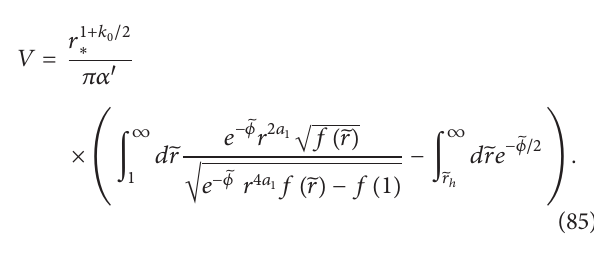
Figure4:Atgiventemperature 𝑇 = 1 thebindingenergyofparticles for 𝜂 = 0 (solid), which is the same as the one of monopoles. The dashed or dotted one represents the binding energies of particles or monopoles for 𝜂 = 1 , respectively, where we set 𝜋𝛼 󸀠 = 1 and 𝐷 = 4